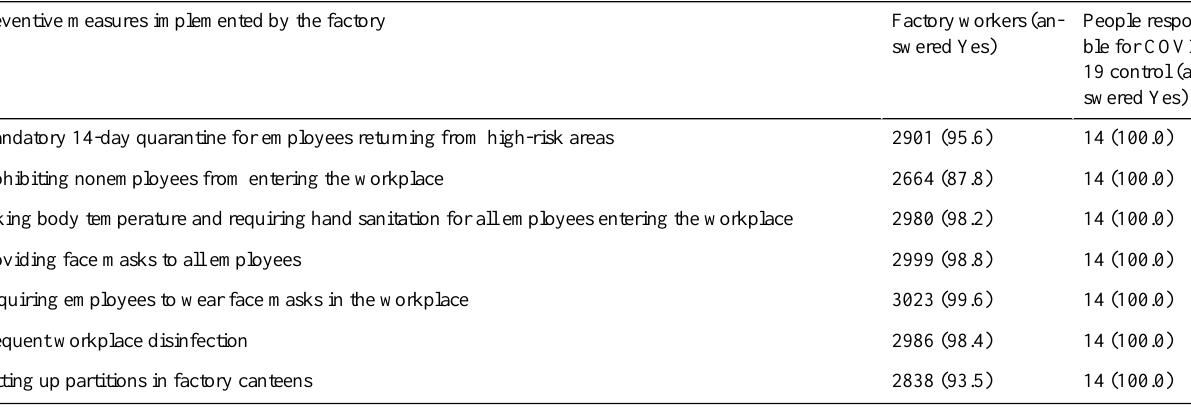
Table 5. Responses to items measuring social-structural–level variables (n=3035), n